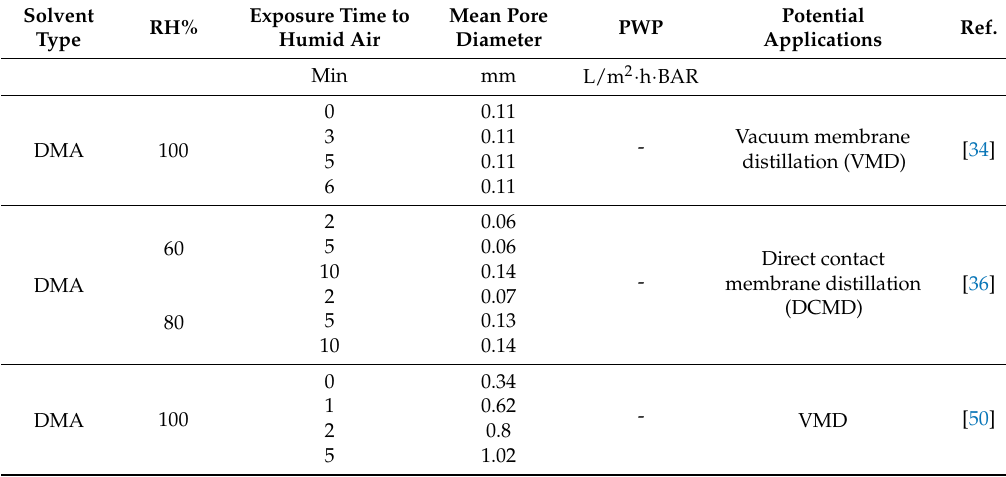
Table 5. Comparison between the most relevant results obtained in this work and those reported in literature related to PVDF membrane preparation via